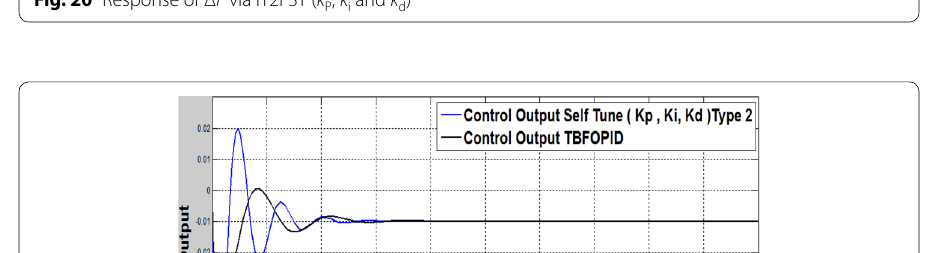
Fig. 20 Response of Δ F via IT2FST ( k P , k i and k d )